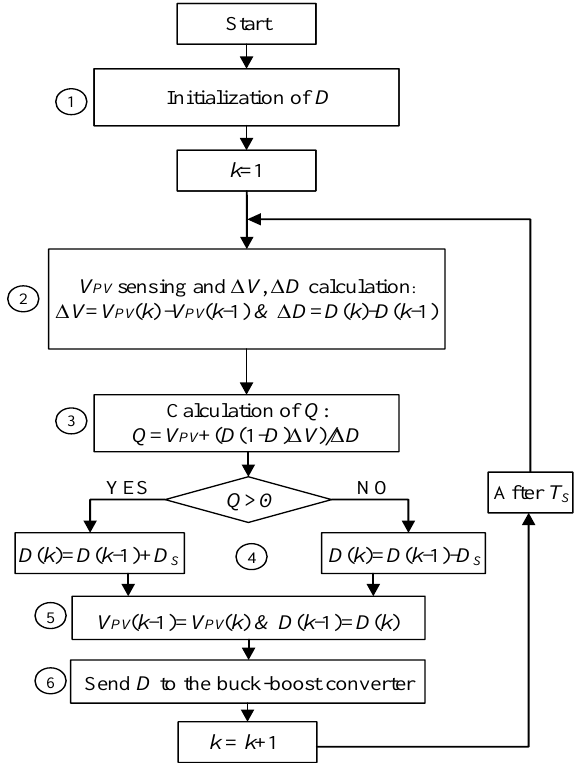
Figure 7. Flowchart of the proposed CSL-MPPT method.